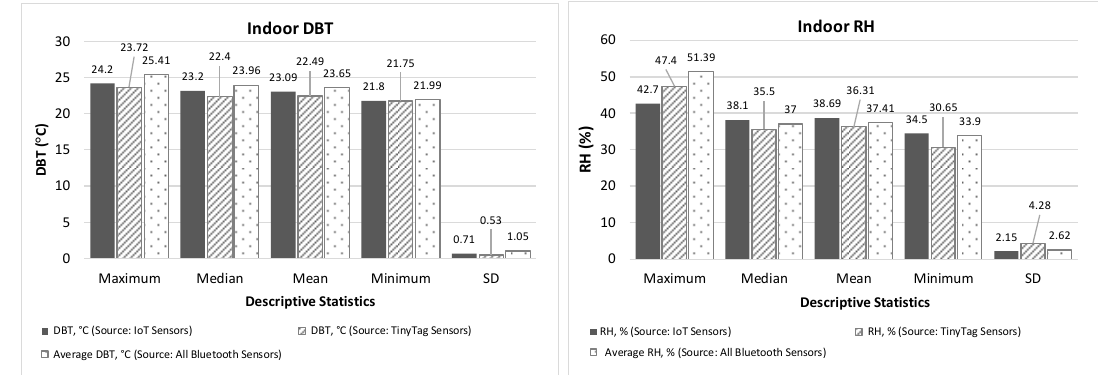
Figure 14. Comparison of statistical values of DBT and RH recorded at the lecture room during a workshop (source: data collected from IoT, TinyTag, and portable Bluetooth sensors).